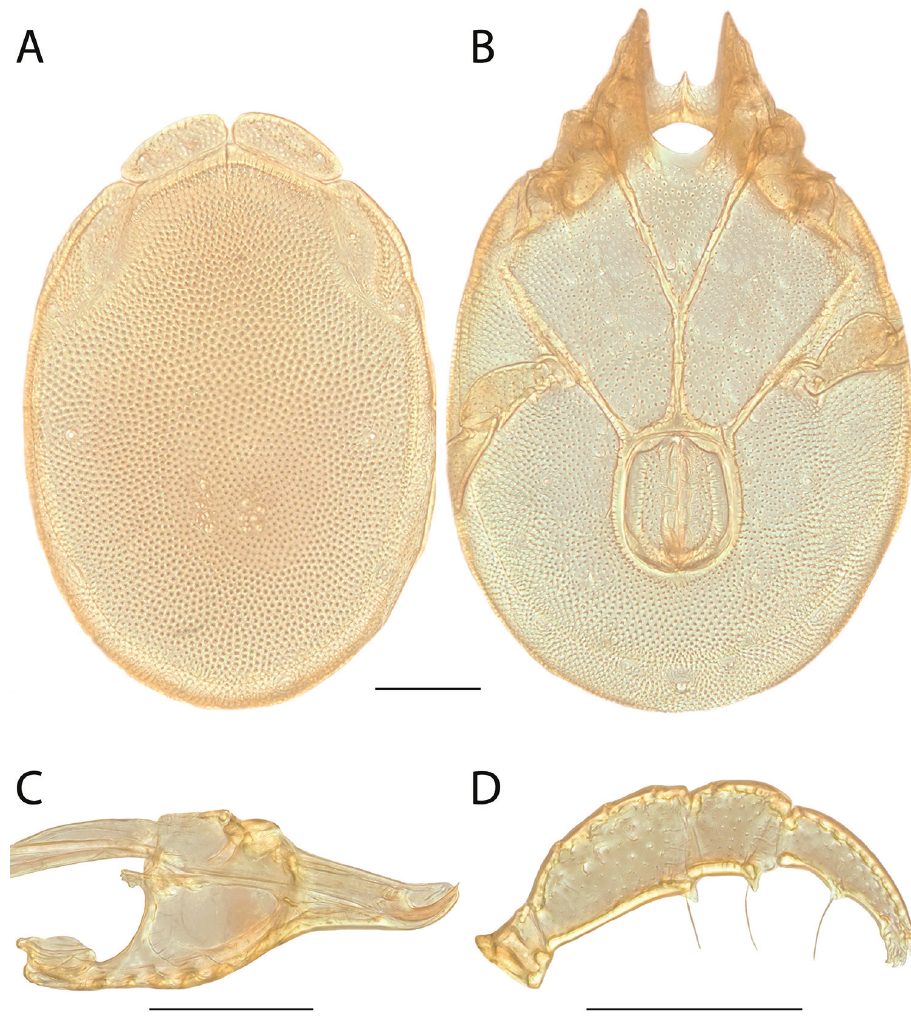
Figure 157. Torrenticola mulleni sp. n. female: A dorsal plates B venter (legs removed) C subcapitulum D pedipalp (setae not accurately depicted). Scale = 100